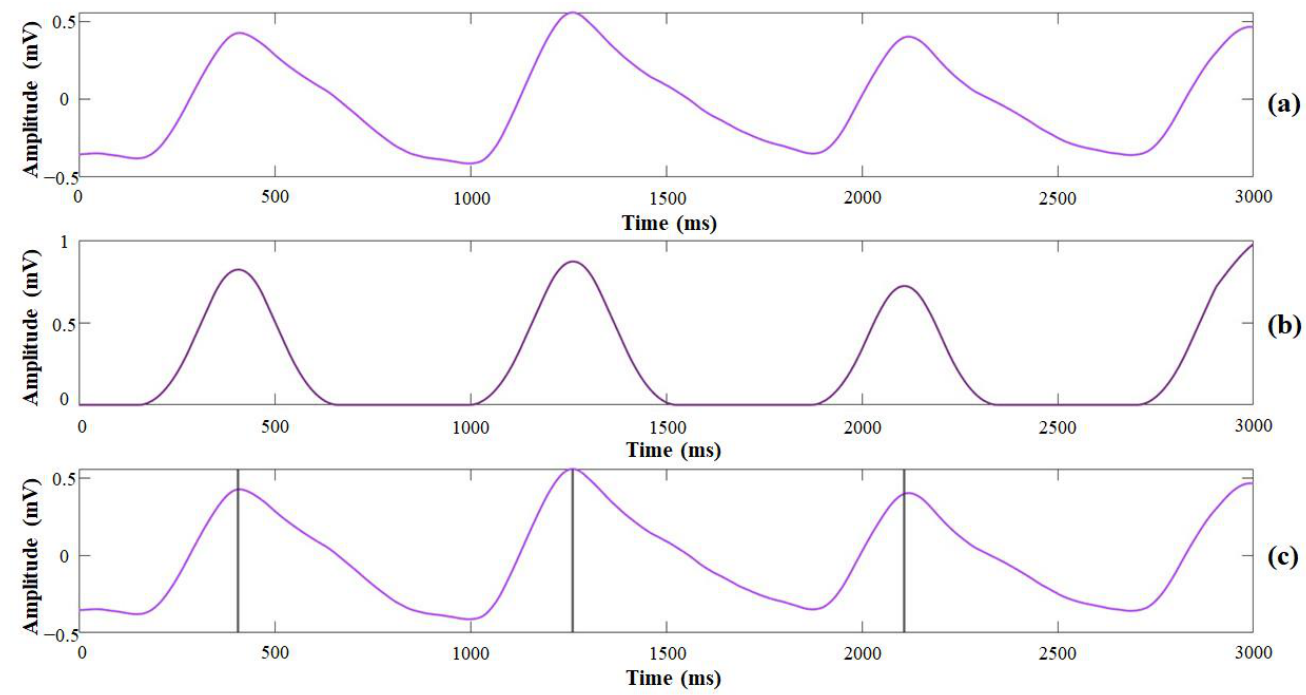
Figure 3. The procedure of peak point detection from the PPG signal: ( a ) recorded PPG signal; ( b ) smooth Shannon entropy envelope; ( c ) detected pulse onset and peak points.